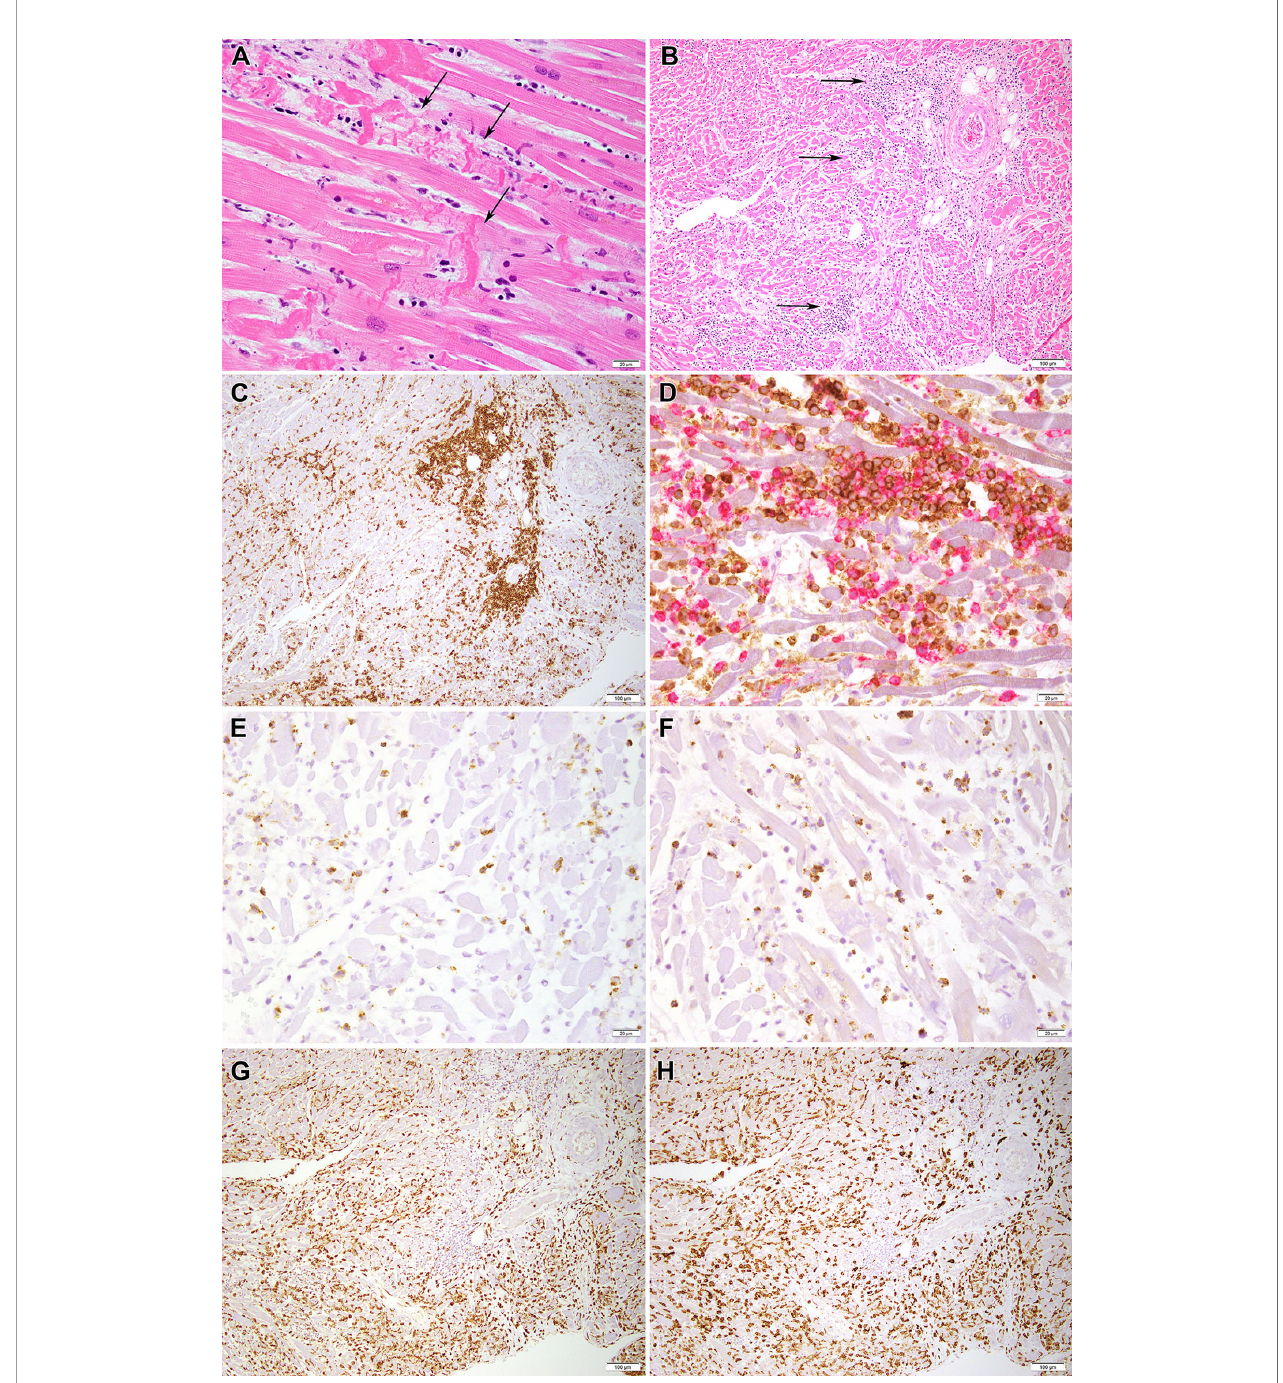
FIGURE 1 | Histopathology images of myocardium. (A) H&E section from the myocardium shows contraction band myocyte necrosis (arrows) (40x). (B) H&E section from the myocardium shows an in fl ammatory in fi ltrate mostly composed of lymphocytes and macrophages (arrows) (10x) as seen better in (C) by an immunohistochemical stain for CD3, which marks T lymphocytes (10x). (D) A double immunohistochemical stain highlights the presence of CD8-positive T cells (red chromogen) and CD4-positive T cells (brown chromogen); low grade expression by CD4 marks macrophages (40x); (E, F) show the presence of scattered cytotoxic T cells positive for perforin (40X) and granzyme B (40X), respectively. (G, H) Presence of numerous histiocytes/macrophages is con fi rmed by CD68 (10x) and CD163 (10x) staining,